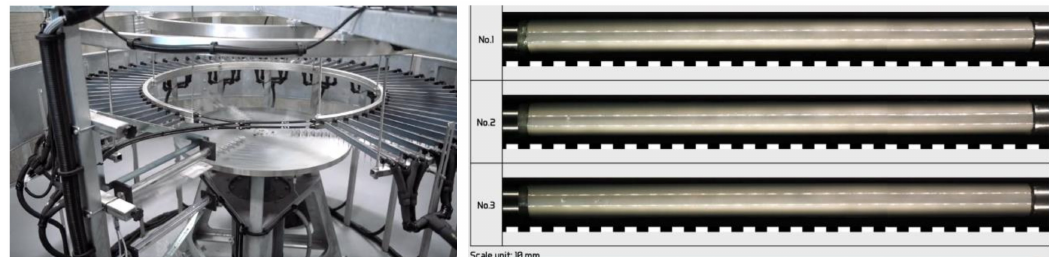
Figure 14. Application execution steps of RET testing coupons used in this work (DNVGL-RP-0171).